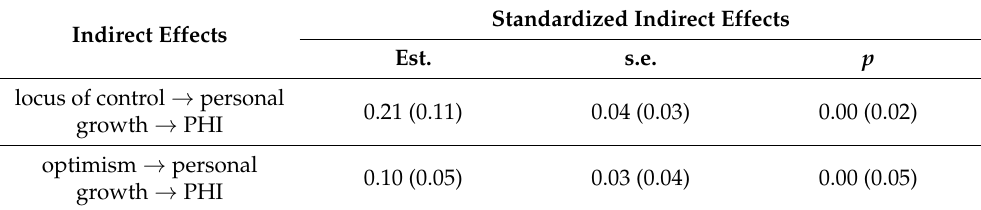
Table 3. Indirect effects of the estimated multi-group